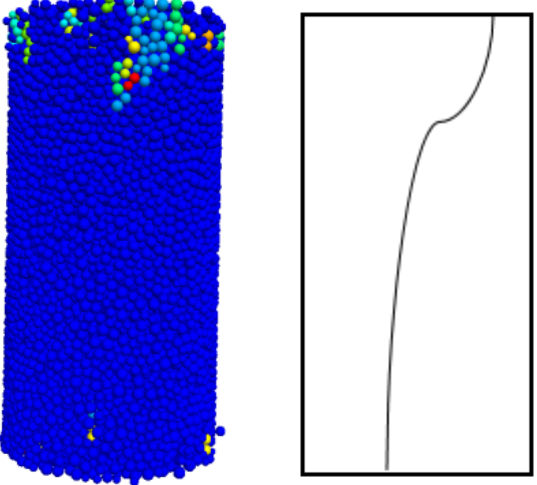
Figure 8. Transjuane Sandstone specimen after uniaxial failure.